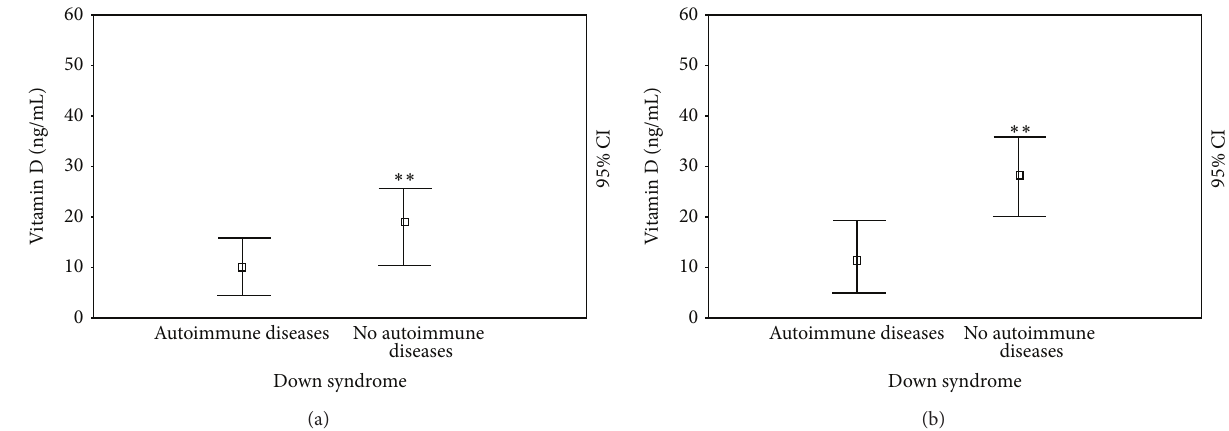
Figure 3: 25(OH)D levels (ng/mL) at cross-sectional (a) and longitudinal (b) evaluation in patients with Down syndrome with and without autoimmune diseases. ∗ 𝑃 < 0.05 ; ∗∗ 𝑃 < 0.005 ; ∗∗∗ 𝑃 < 0.001